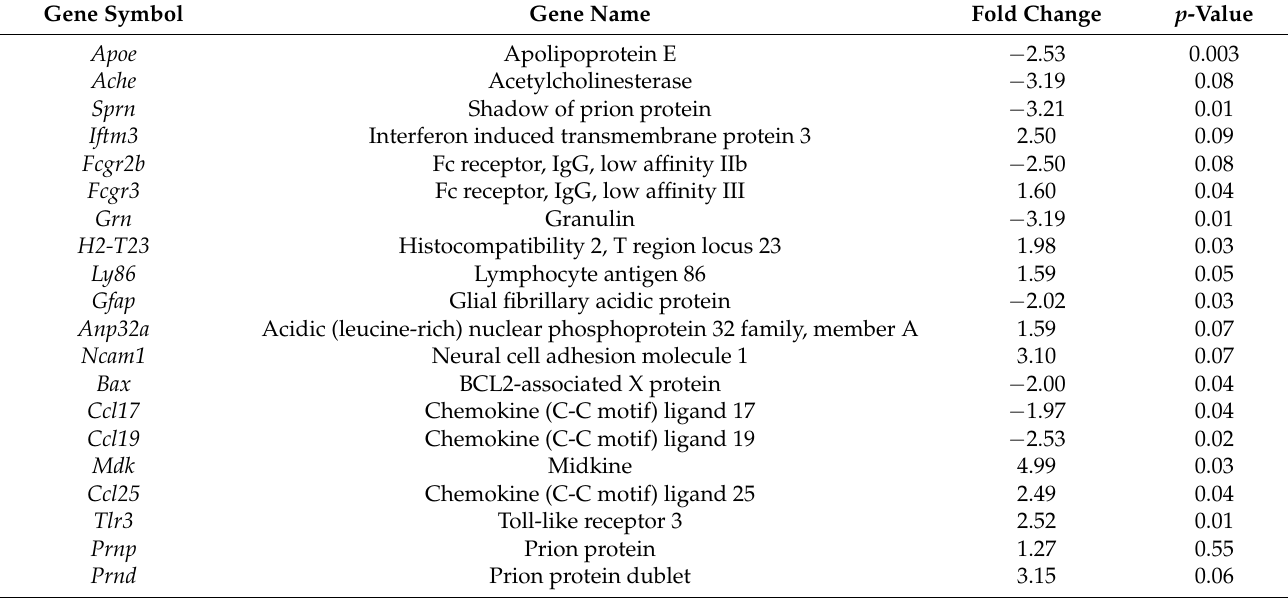
Table 2. List of differentially expressed genes in the brains of FVB/N mice, treated with LPS, at terminal stage. Gene Symbol